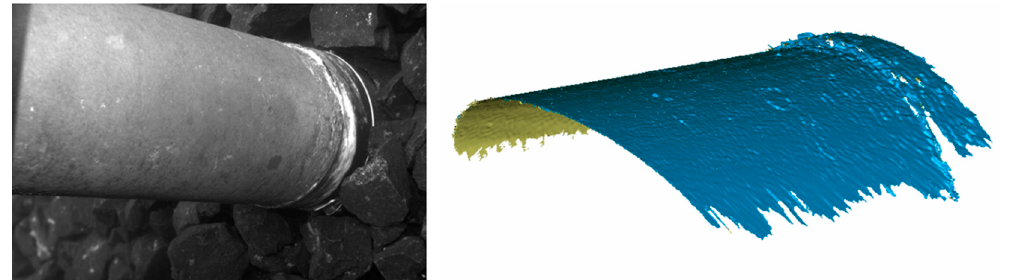
Figure 10. Selected images from fringe sequence: parts of Gray-code sequence ( a , c ) and sinusoidal fringes ( b , d ) taken from underwater measurements of a pipe.